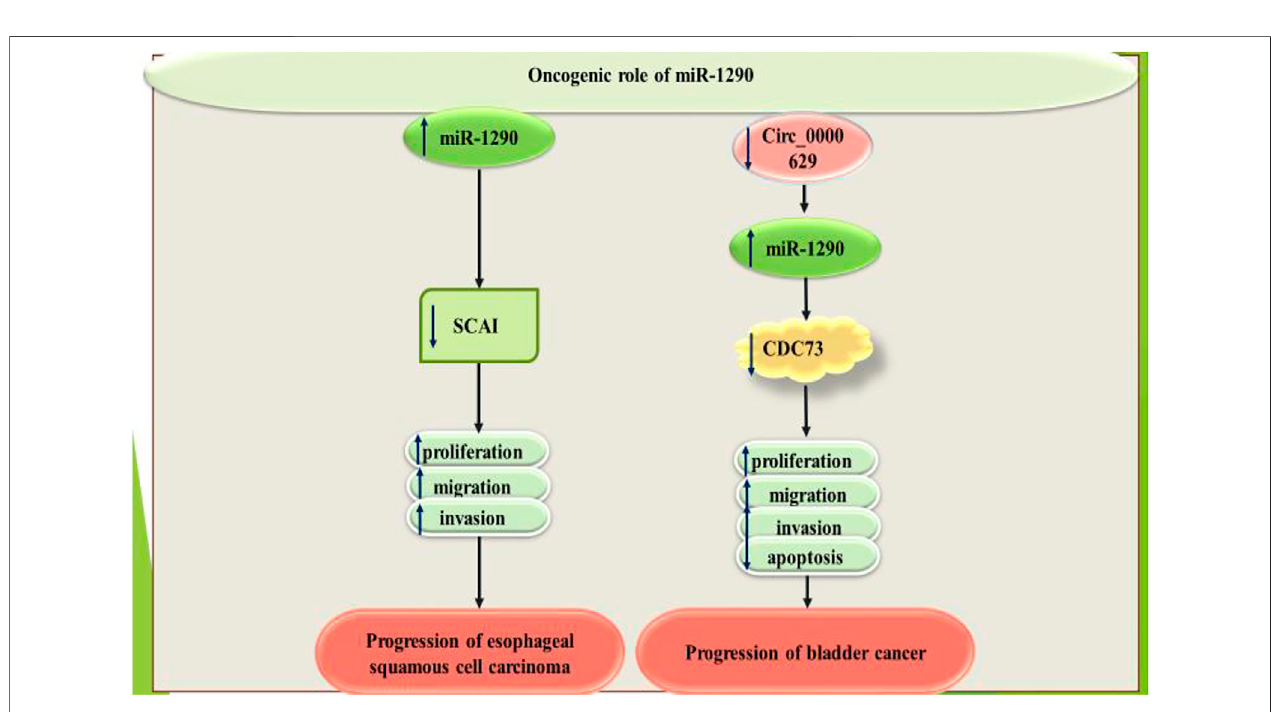
FIGURE 4 | Oncogenic role of miR-1290 in esophageal and bladder cancers.